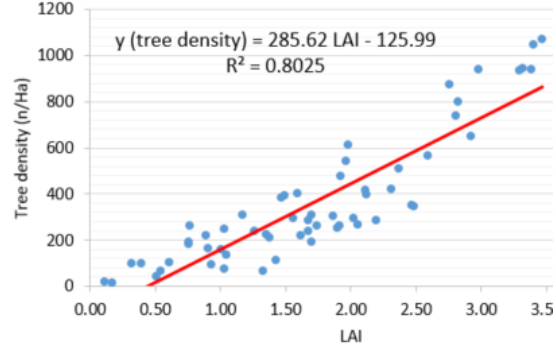
Figure 14 . Regression between tree density and LAI derived from hemispherical